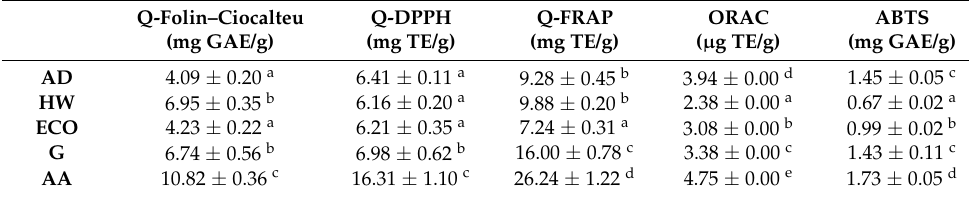
Table 1. Overall antioxidant capacity of kiwi samples measured using different methodologies (extraction-dependent and direct by